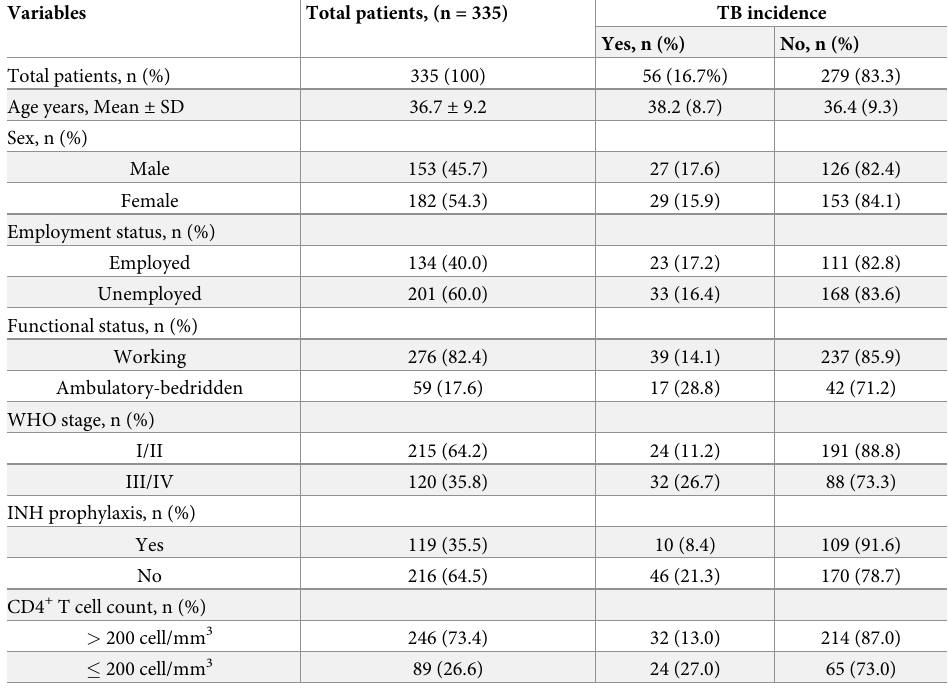
Table 2. TB incidence with different baseline demographic and clinical profiles of study participants living with HIV in Gondar.